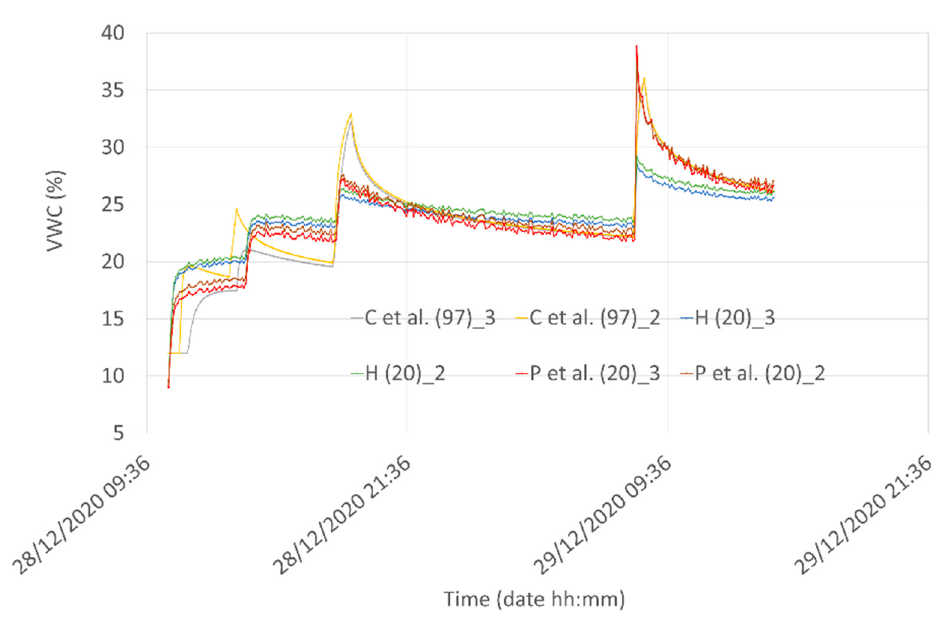
Figure 19. Comparison among the water infiltration and redistribution “C” model for Silty Loam at a depth of 2 and 3 cm with the VWC obtained from the voltage measured by Node #1 using Equation (2) (“P” curves) and Equation (3) (“H” curves).